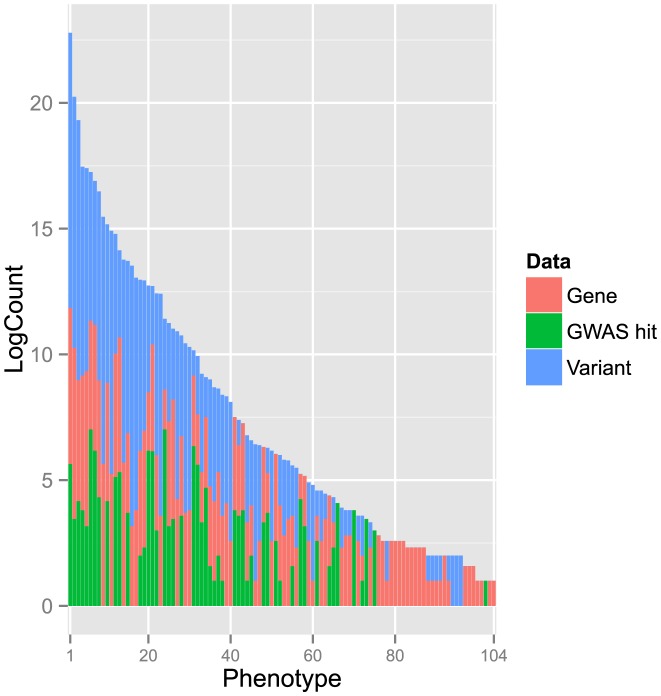
Distribution of annotated genes, GWAS hits and high penetrance variants for phenotypes analyzed in this study.Phenotypes are ordered by total counts of annotated genes and variants that we found. Counts are shown on a log scale for easier visualization. For each phenotype the (log) count of annotated genes is colored red, GWAS hits green, and high penetrance variants blue. Some phenotypes have a very large number of annotations and others have very few. For 42 phenotypes, we did not find any annotated genes or variants.